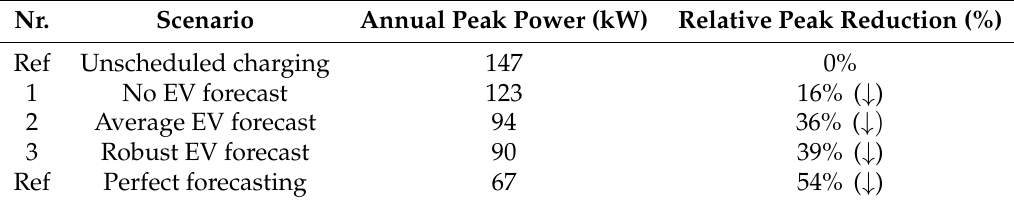
Table 3. Annual peak power across